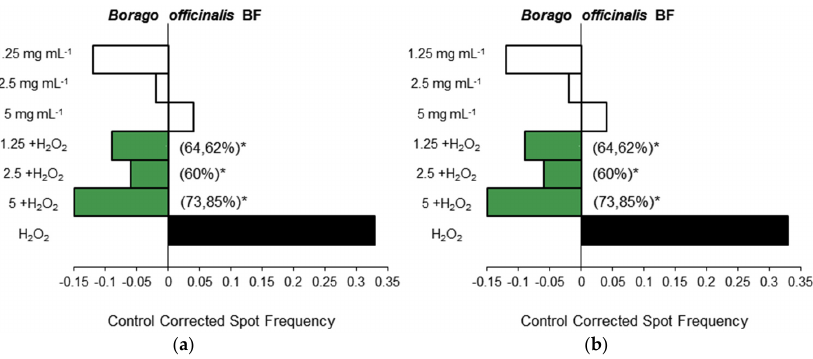
Figure 1. Antigenotoxic activity of Borago officinalis plant material: ( a ) blue flowered (BF) and ( b ) white flowered (WF) plant material expressed as mutation frequency corrected to control. Strength of inhibition on the capability of H 2 O 2 (0.12 M) to induce mutated cells is also showed (Inhibition Percentage in brackets). White columns correspond with tested concentrations of simple treatments, green with combined treatments and black column corresponds to spot frequencies induced by H 2 O 2 . * Significance levels with respect to the positive control (H 2 O 2 ) group (p ≤ 0.05).